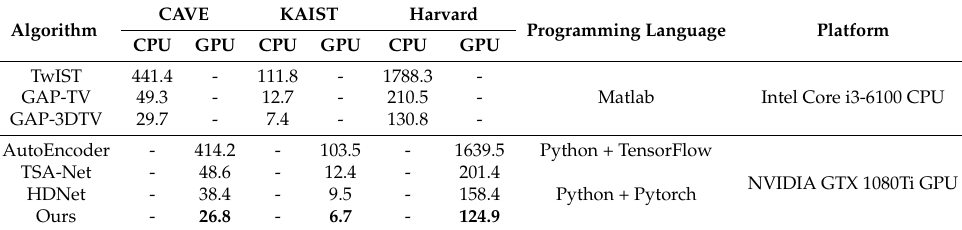
Table 3. CPU and GPU execution time (second) comparison of different methods on the CAVE, KAIST, and Harvard